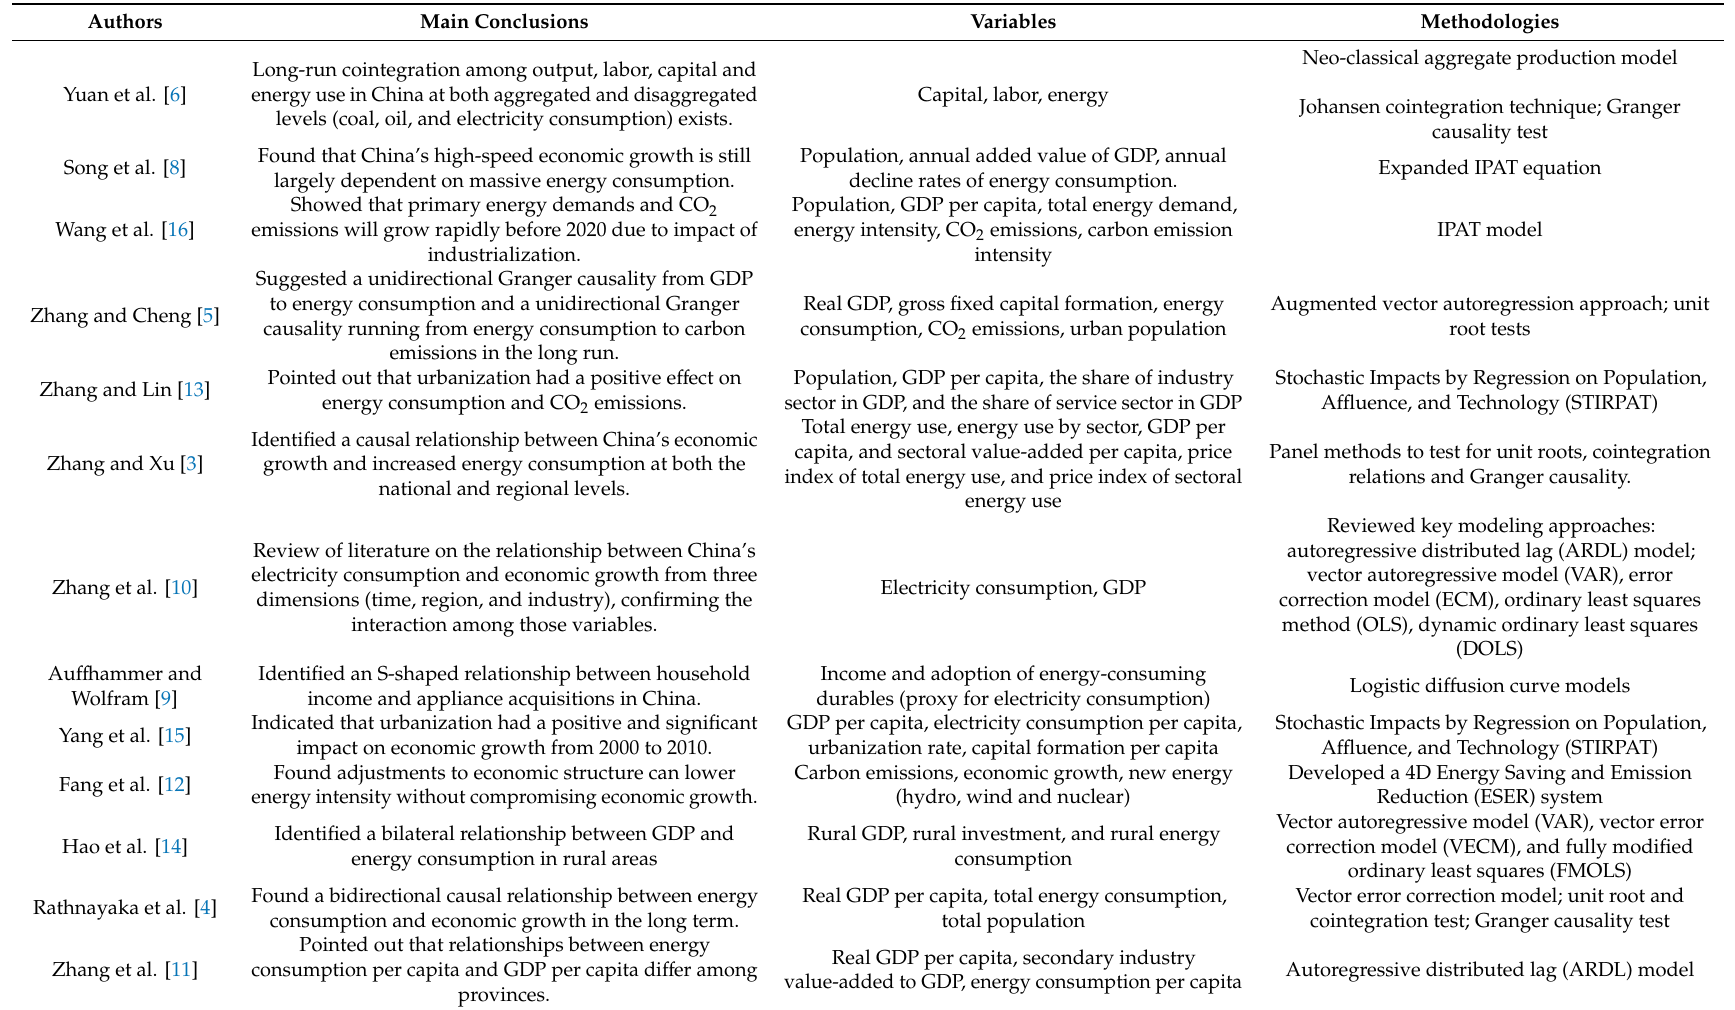
Table 1. Summary of Literature Review: Conclusions, Variables, and